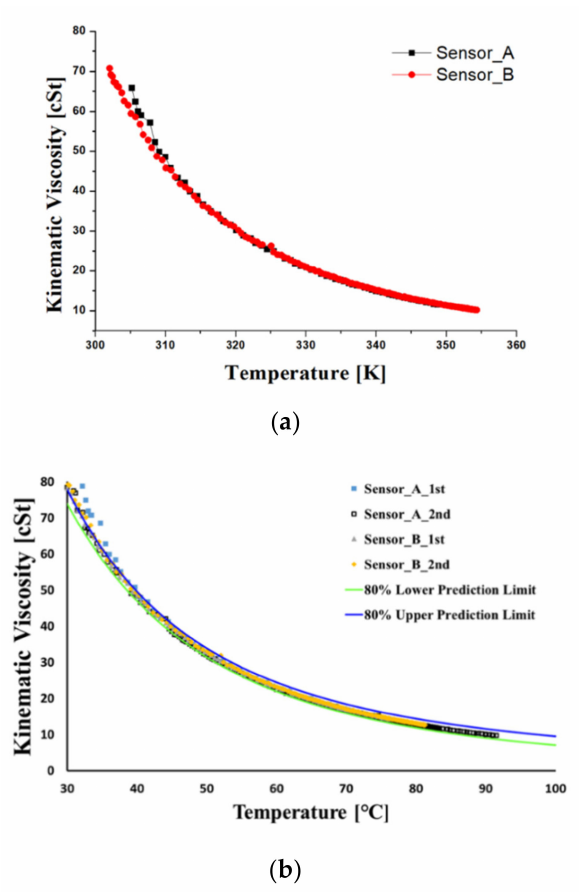
Figure 5. The correlation between kinematic viscosity and temperature using the Vogel model. ( a ) Oil sensor signal of kinematic viscosity at varying temperatures. ( b ) The analysis of regression and prediction limits for kinematic